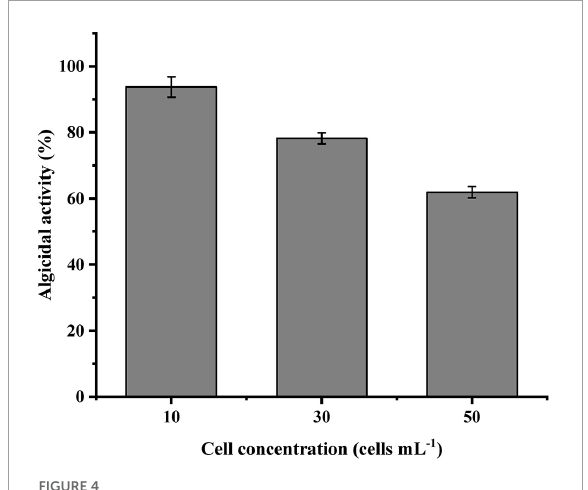
FIGURE4 Algicidal effect of strain LD-B6 at different Noctiluca scintillans initial cell densities. The error bars represent standard deviations ( n =